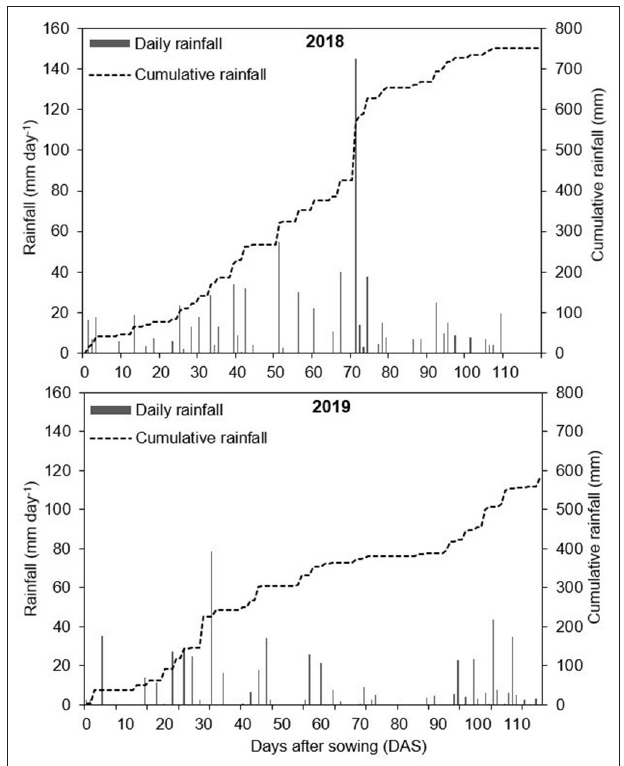
FIGURE 2 | Rainfall distribution from sowing to harvest in 2018 and